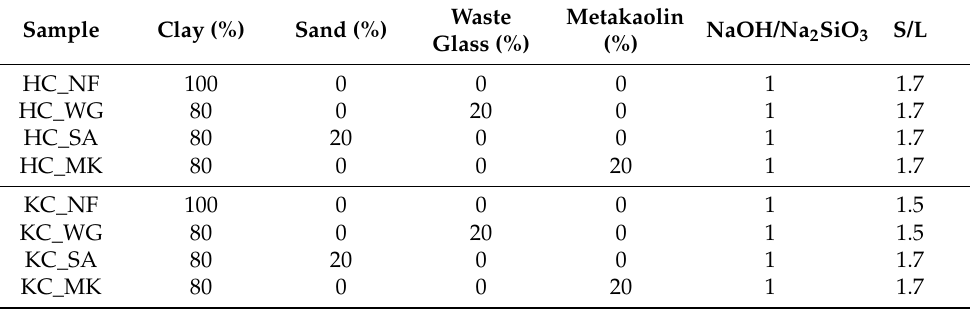
Table 1. Formulations of samples made with HC (halloysitic clay), KC (kaolinitic clay), and SC (illitic/smectitic clay). S/L = solid to liquid ration, where solid is the clay + filler content.